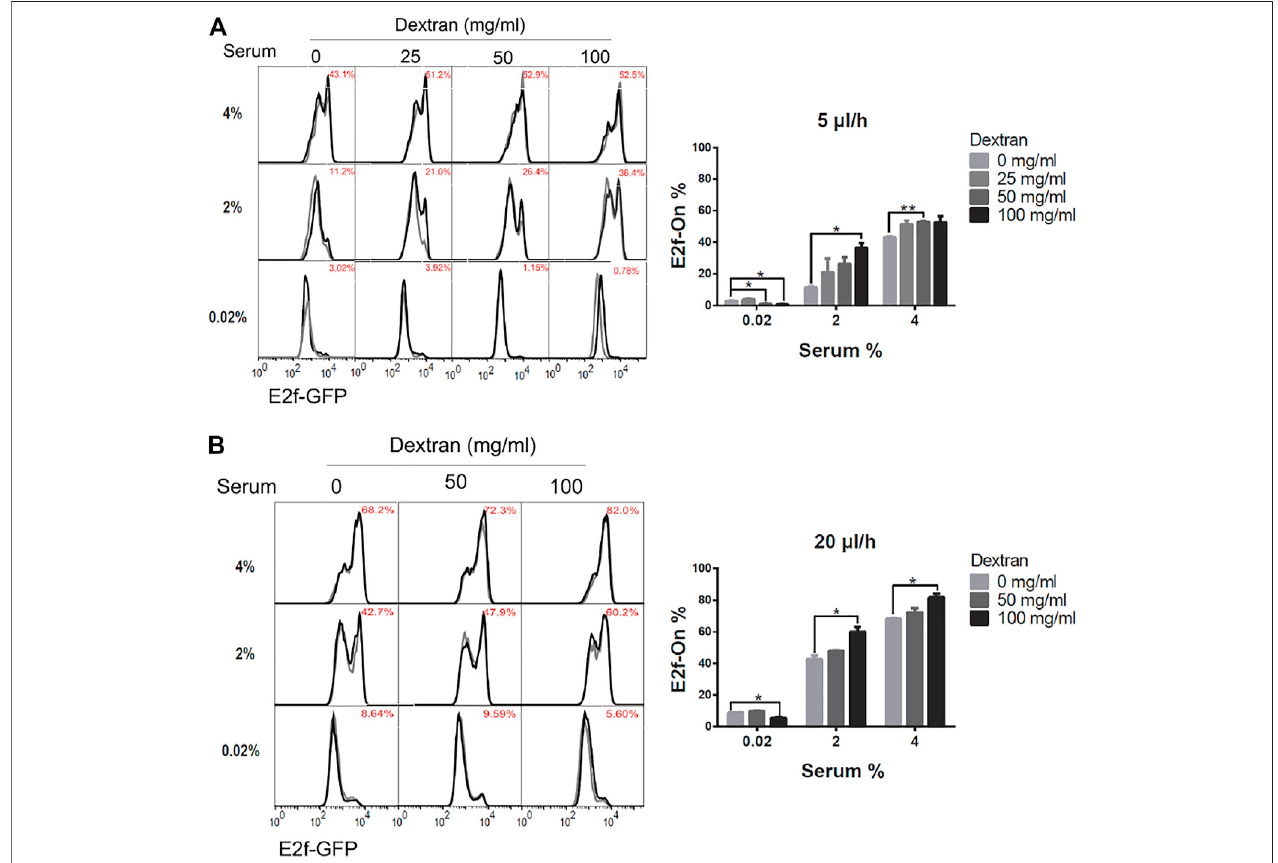
FIGURE 4 | Higher shear stress leads to shallower quiescence. REF/E23 cells seeded in micro fl uidic devices were induced to and maintained in quiescence by culturing them in serum-starvation medium for 4 days under the fl ow rates of 5 μ l/h (A) and 20 μ l/h (B) . Dextran at the indicated concentrations was dissolved in the serum-starvation medium. Cells were subsequently stimulated with serum at the indicated concentrations for 26 h, and the E2f-On% were assayed. (Left) E2f-GFP histogramswithrednumbersindicatingtheaverageE2f-On% fromduplicatesamples(blackandgrey).(Right) StatisticbarchartoftheE2f-On%incellpopulations (from the left) as a function of dextran concentration (in serum-starvation) and serum concentration (in serum-stimulation). Error bars, SEM ( n = 2), * p < 0.05, ** p < 0.01.